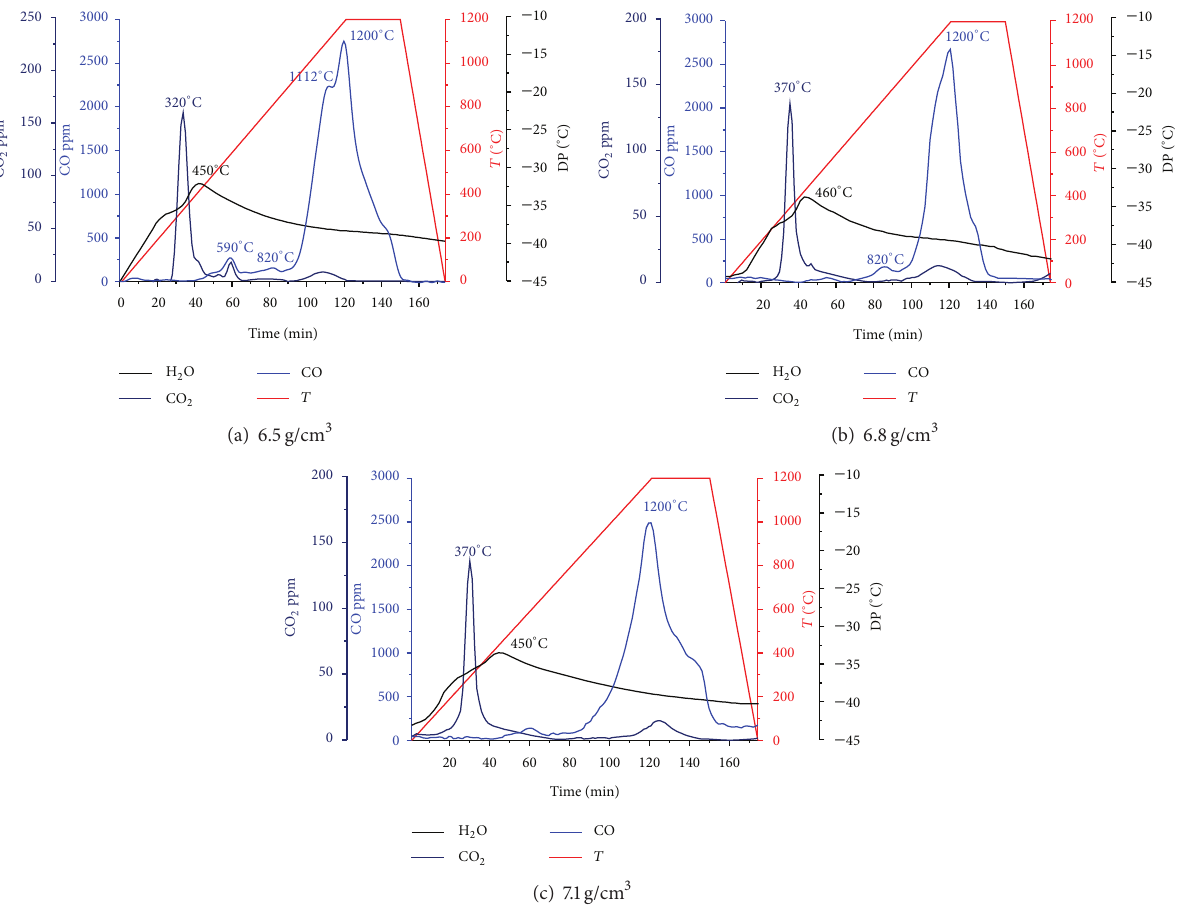
Figure 12: (a)–(c) Spectra of processing gas composition during sintering of the AstCr + 0.5% C components with densities of 6.5, 6.8, and 7.1g/cm 3 at 1200 ∘ C for 30 min in N 2